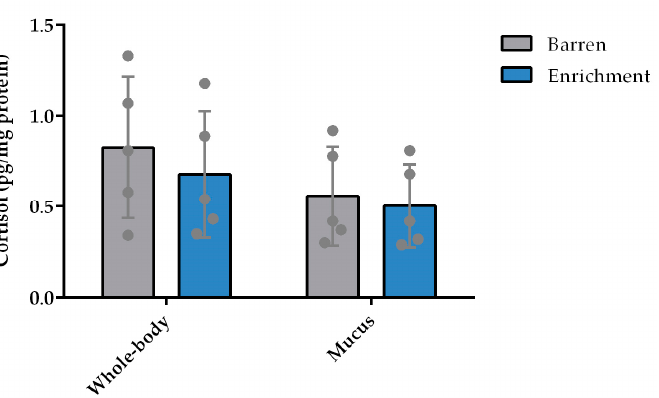
Figure 5. Whole-body homogenates and skin-mucus cortisol levels (pg/mg protein) after a 6-month exposure to enriched and barren housing (n = 5). Data represented as mean ± standard deviation. Each point represents one experimental unit, i.e., a tank.